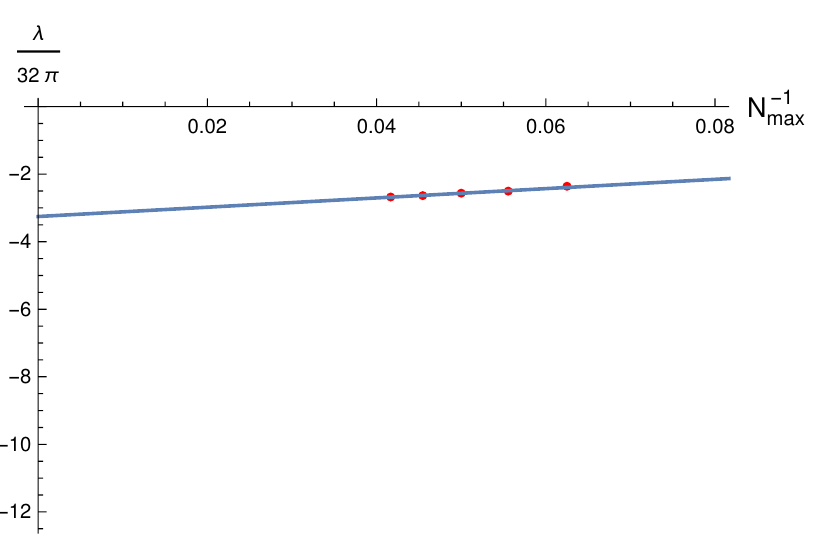
Figure 2 . Lower bound on the quartic coupling λ as a function of N − 1 are indicated by the red dots. They correspond to N max = 10 , 16 , 18 , 20 , 22 and 24 . The blue line represents the linear fit of the three points N max = 20 , 22 and 24 . It is described by λ/ (32 π ) = − 3 . 25 + 13 . 76 N − 1 equation. The spin cut-off parameter used here is L max = N max + 20 max